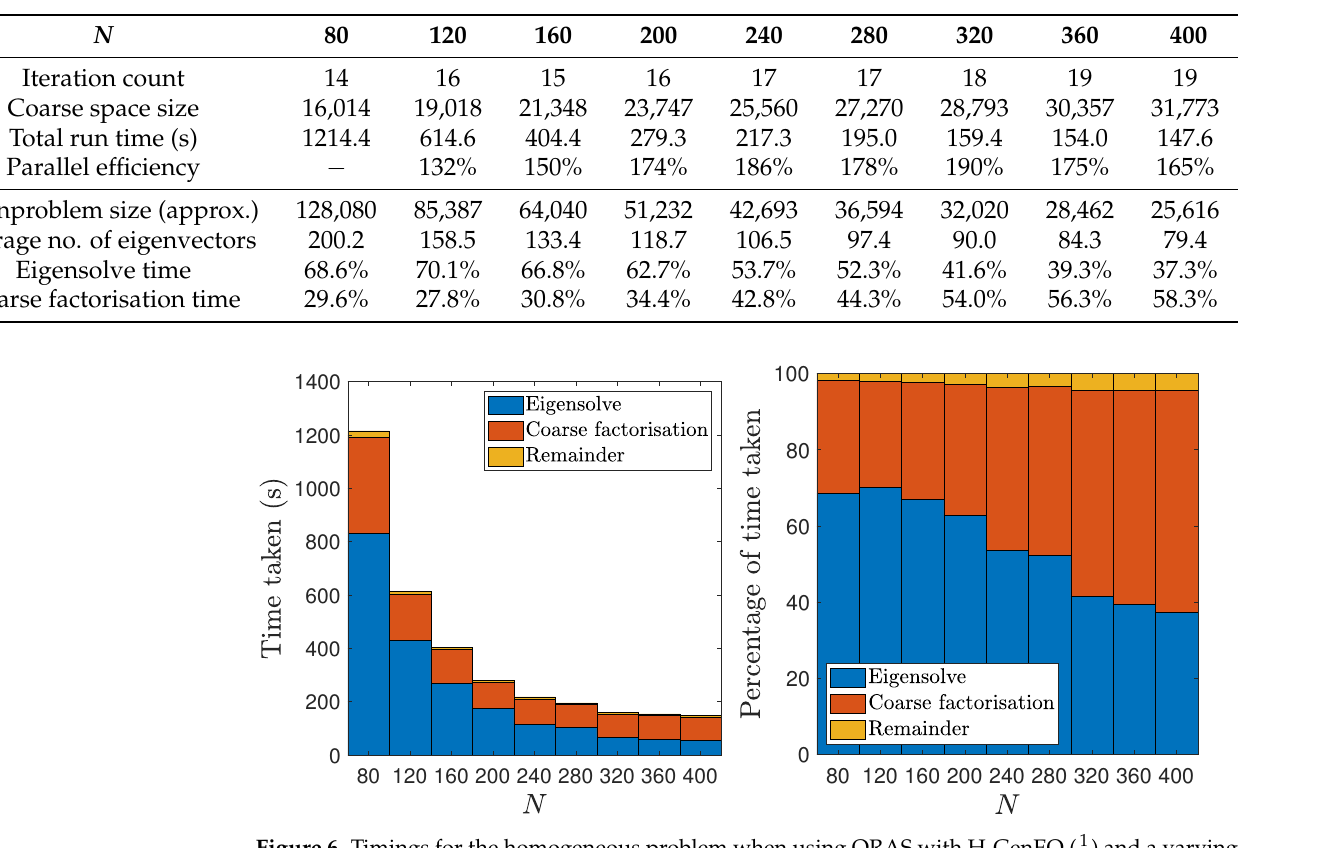
) and a varying 2